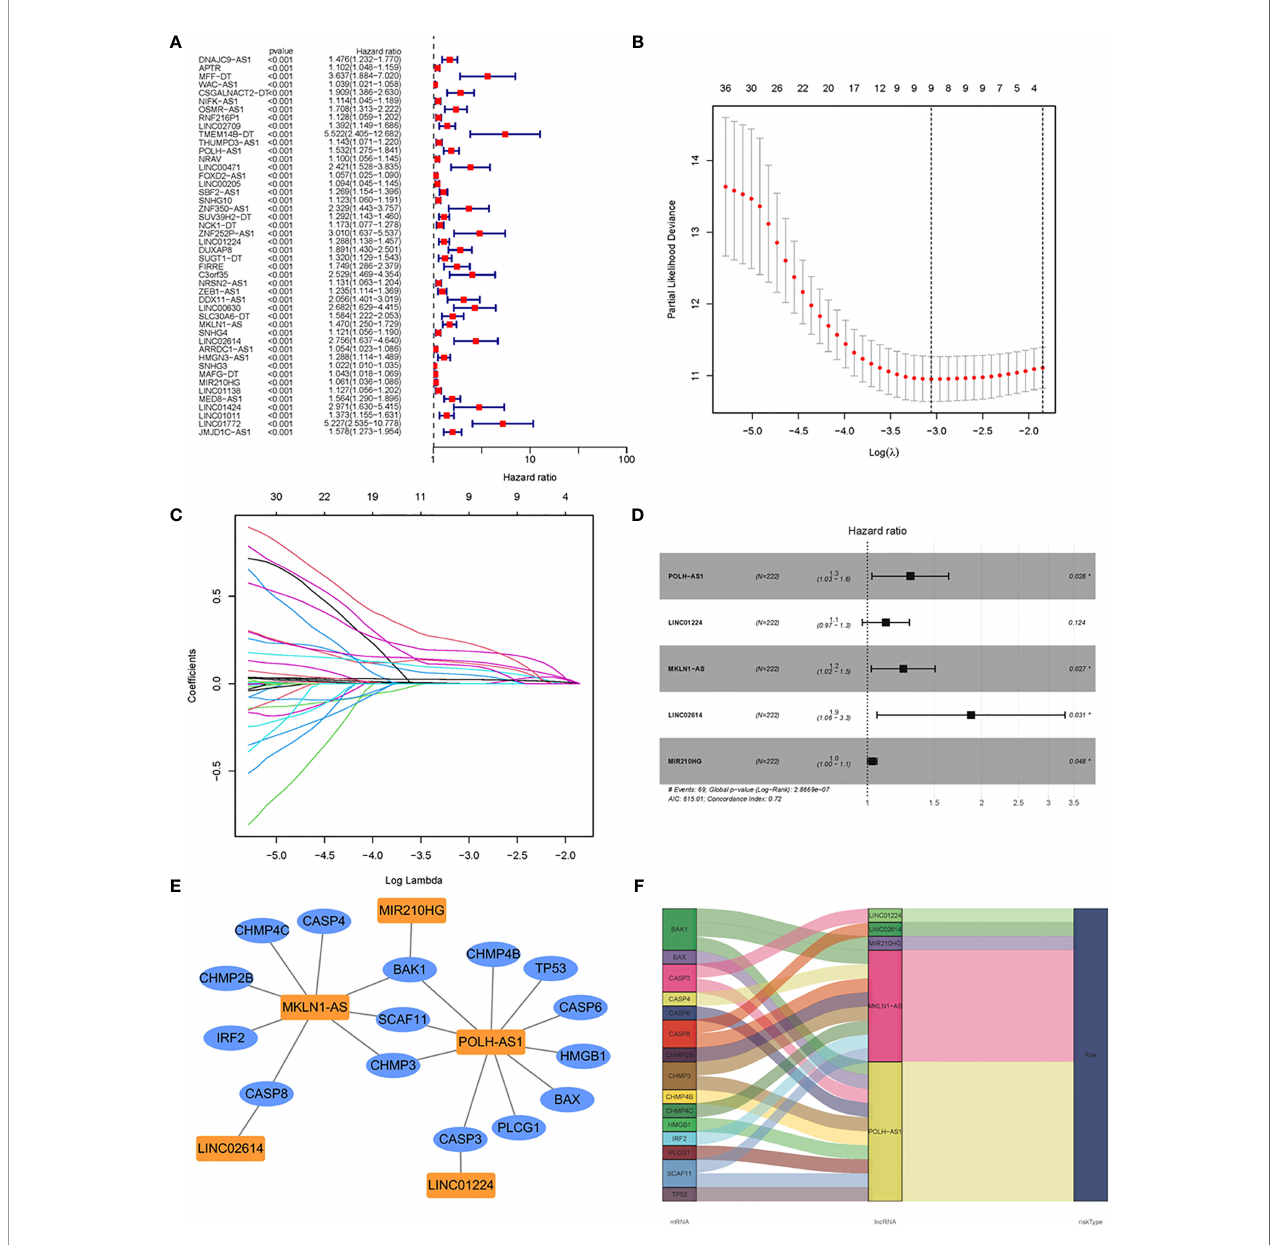
FIGURE 3 | Construction of prognostic risk signature for patients with HCC based on pyroptosis-related lncRNAs in the training set. (A) Forest plot of 46 pyroptosis-related lncRNAs associated with overall survival of HCC patients based on univariate Cox regression analysis. (B) Distribution plot of the partial likelihood deviation of the LASSO regression. Nine variables were retained when the partial likelihood deviation reached the minimum (log lambda = – 3.1). (C) Distribution plot of the LASSO coef fi cient. (D) Multivariate Cox regression analysis identi fi ed fi ve pyroptosis-related lncRNAs for the construction of a prognostic model. (E) Prognostic co-expression network of the fi ve pyroptosis-related lncRNAs and mRNAs. (F) Sankey diagram of the relationship between lncRNAs and mRNAs. * P <